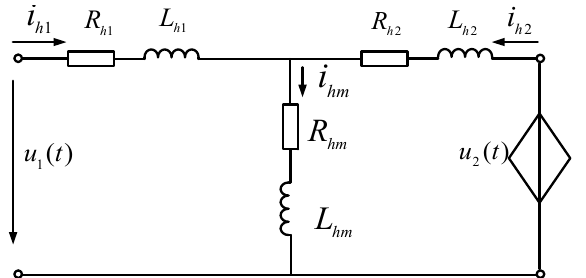
Figure 6. Advanced T equivalent circuit under harmonic